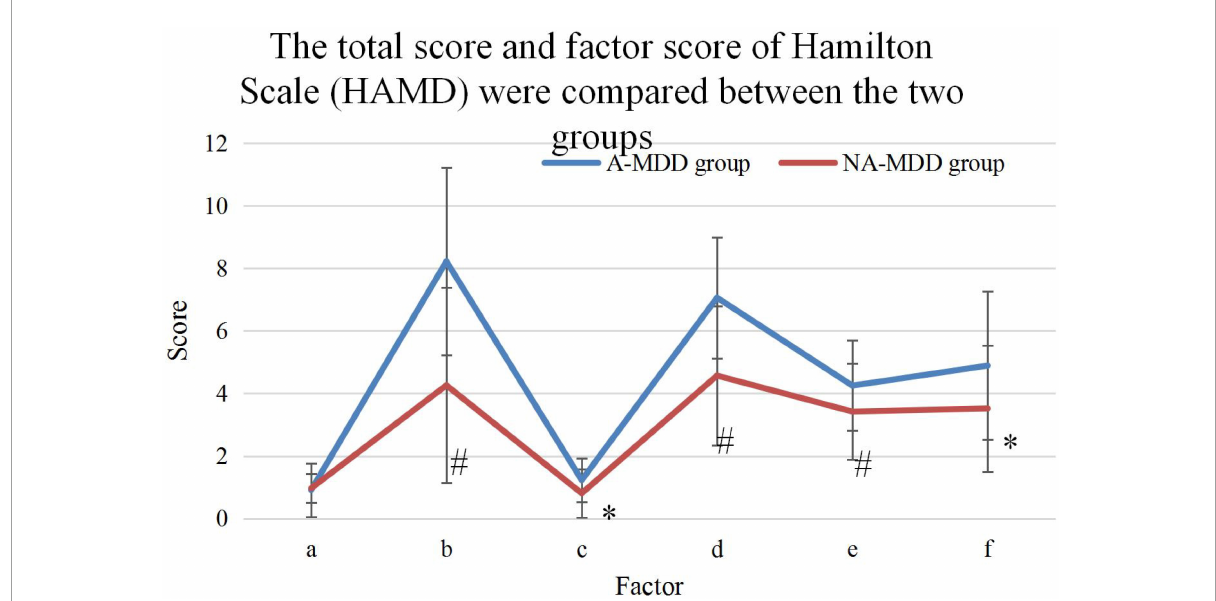
FIGURE5 Comparison of the total and factor scores of the HAMD. ∗ and # Represented P < 0.05 and P < 0.01 compared with the NA-MDD group,